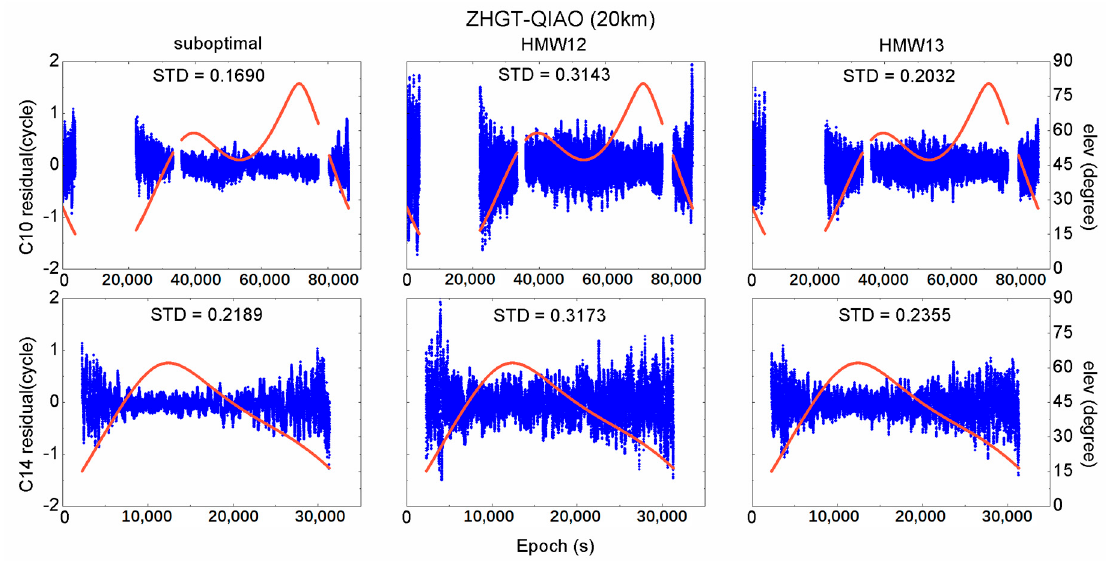
Figure 5. Comparison of ambiguity residuals and the corresponding standard deviations of suboptimal , HMW 12, and HMW 13 combinations for the medium baseline (20 km).